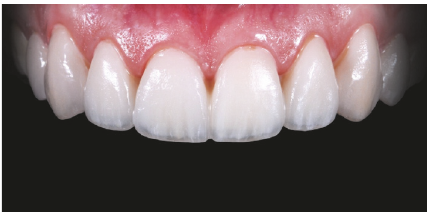
Figure 14: Try-In +2